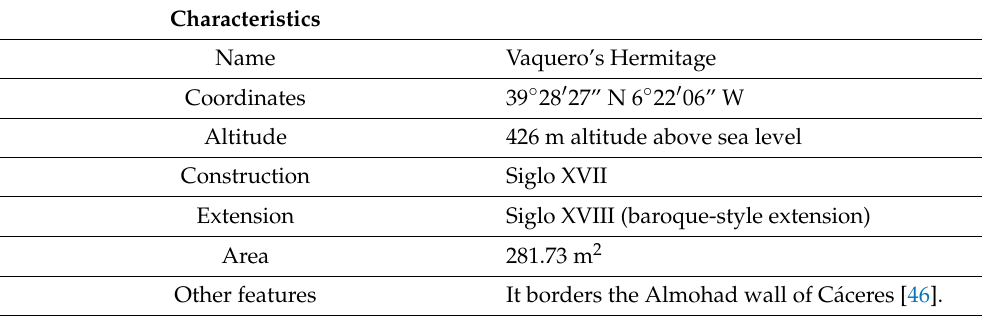
Table 2. Technical characteristics of “Vaquero’s hermitage”.